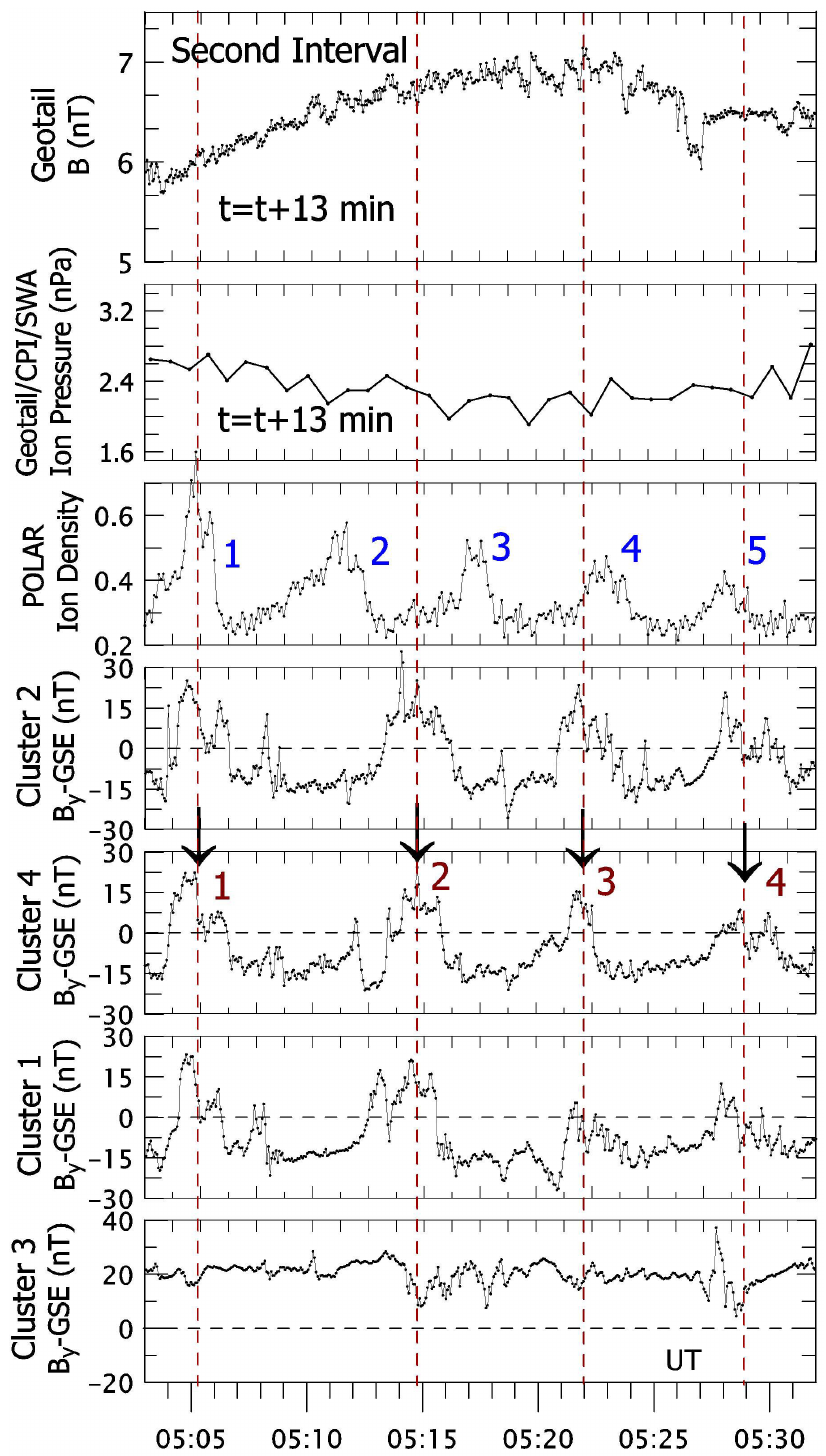
Fig. 8. From top to bottom: Geotail magnetic field amplitude and solar wind ion pressure shifted in time 13min to match the POLAR and Cluster data; POLAR ion density profile, and the B y component of the magnetic field for each of the four Cluster satellites. During this interval Cluster 3 remains inside the magnetopause (B y > 0), whereas the other three Cluster satellites remain in magnetosheath (B y < 0) and enter into the magnetosphere proper only for four short intervals. For the same interval the POLAR ion density shows five complete variation